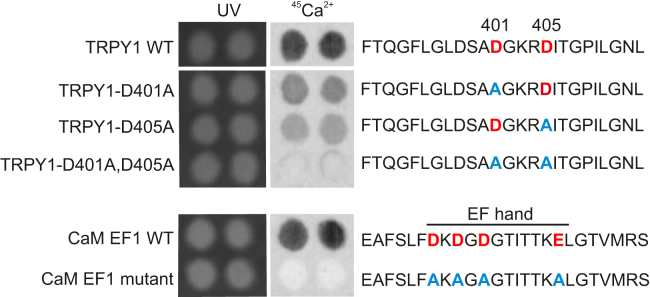
Ca2+ Binding of TRPY1Autoradiographs of 45Ca2+ binding by the 25-mer peptides derived from wild-type (amino acid residues F390 to L414) and D401A and D405A mutant S5-S6 linkers of TRPY1 (upper panel) and by the 25-mer peptides representing wild-type and mutant calmodulin EF hand 1 (CaM EF1, lower panel) as control (two out of four performed blots are shown). Peptides were synthesized and spotted onto hardened cellulose membranes (about 16 nmoles per spot) and incubated with 1.5 μM (1 mCi/L) 45Ca2+. Amounts of peptides spotted were additionally estimated by UV absorption at 312 nm. Aspartate (D) residues are marked in red and alanine (A) residues replacing aspartates are marked in blue. See also Figure S6.